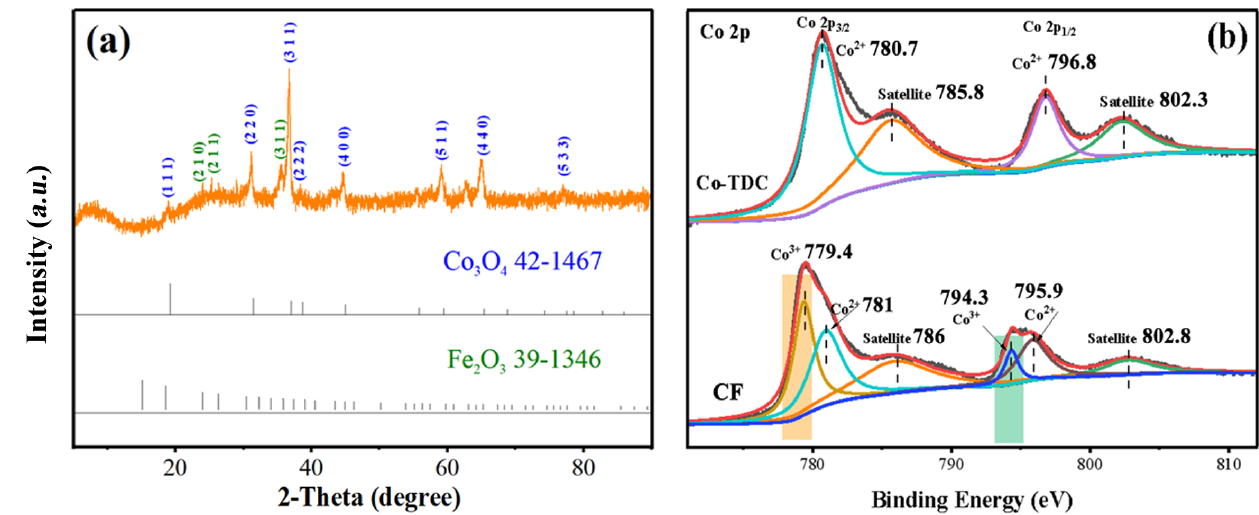
Figure 1. XRD pattern ( a ) and Co 2p XPS spectra ( b ) of as-synthesized CF catalyst.